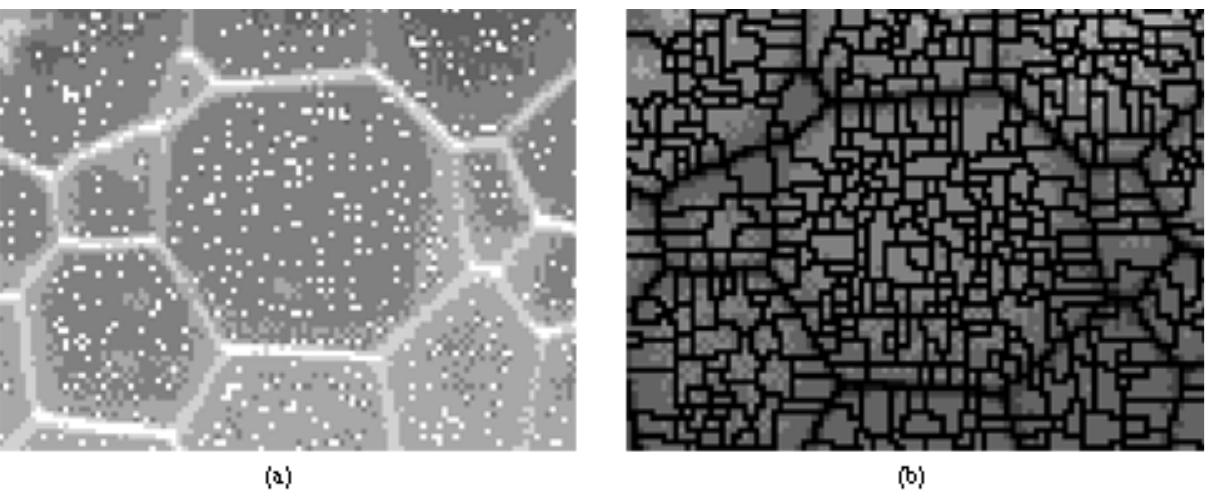
Figure 2. Micrograph of a highly magnified cross section of a uranium oxide sample: (a) minima shown as white spots, and (b) over-segmentation resulting from the watershed transform applied to the non-filtered image